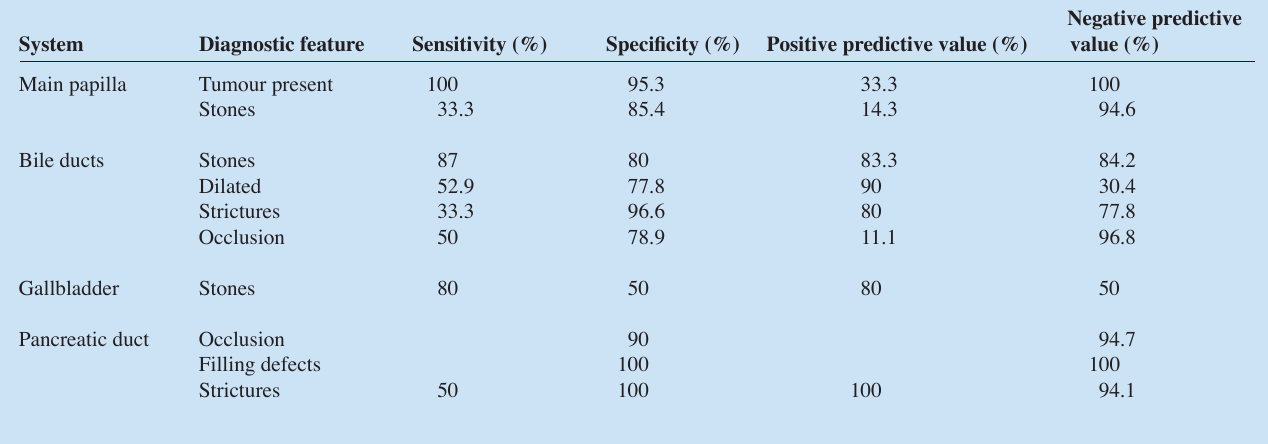
Table II. Main specificity and sensitivity